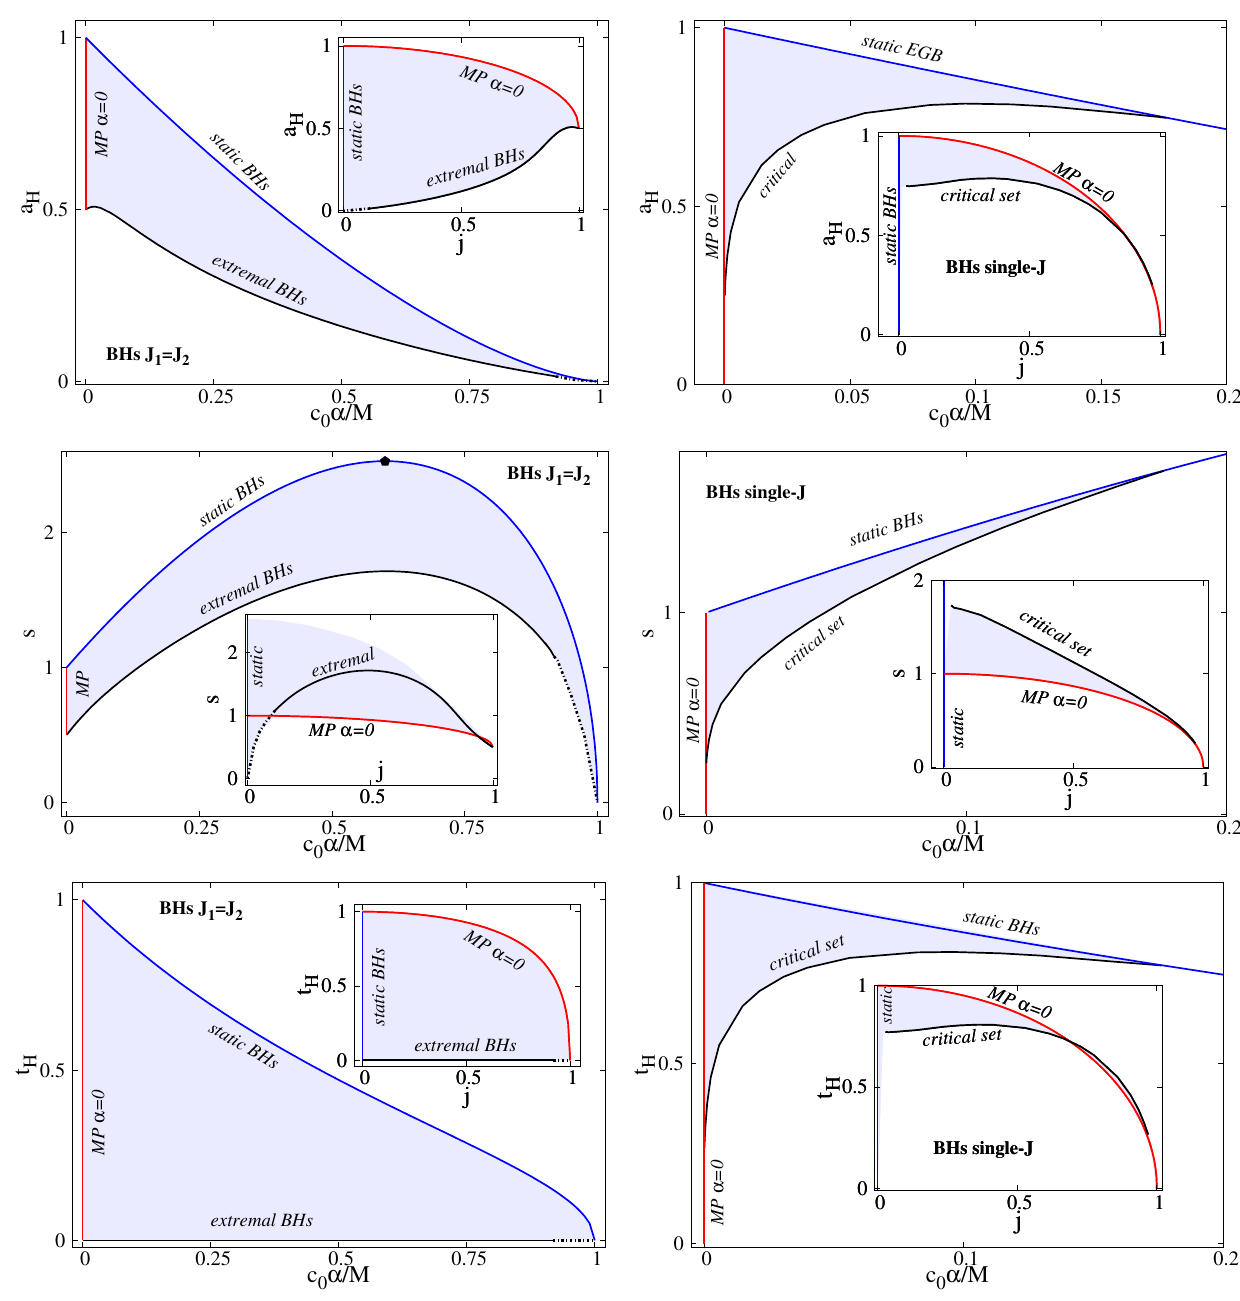
Figure 1. Left panels: The domain of existence of the horizon area, entropy and temperature is shown vs. GB parameter α and vs. J (insets) for EGB black holes with two equal angular momenta. Right panels: The investigated region of the parameter space is shown for EGB black holes with a single plane of rotation. All quantities are normalized with regard to the mass of the solutions, while c 0 = 3 π